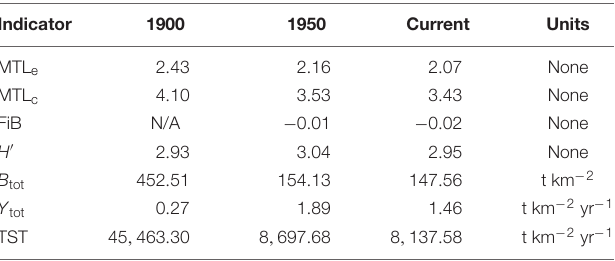
TABLE 3 | Ecosystem indicator values for the three Ecopath